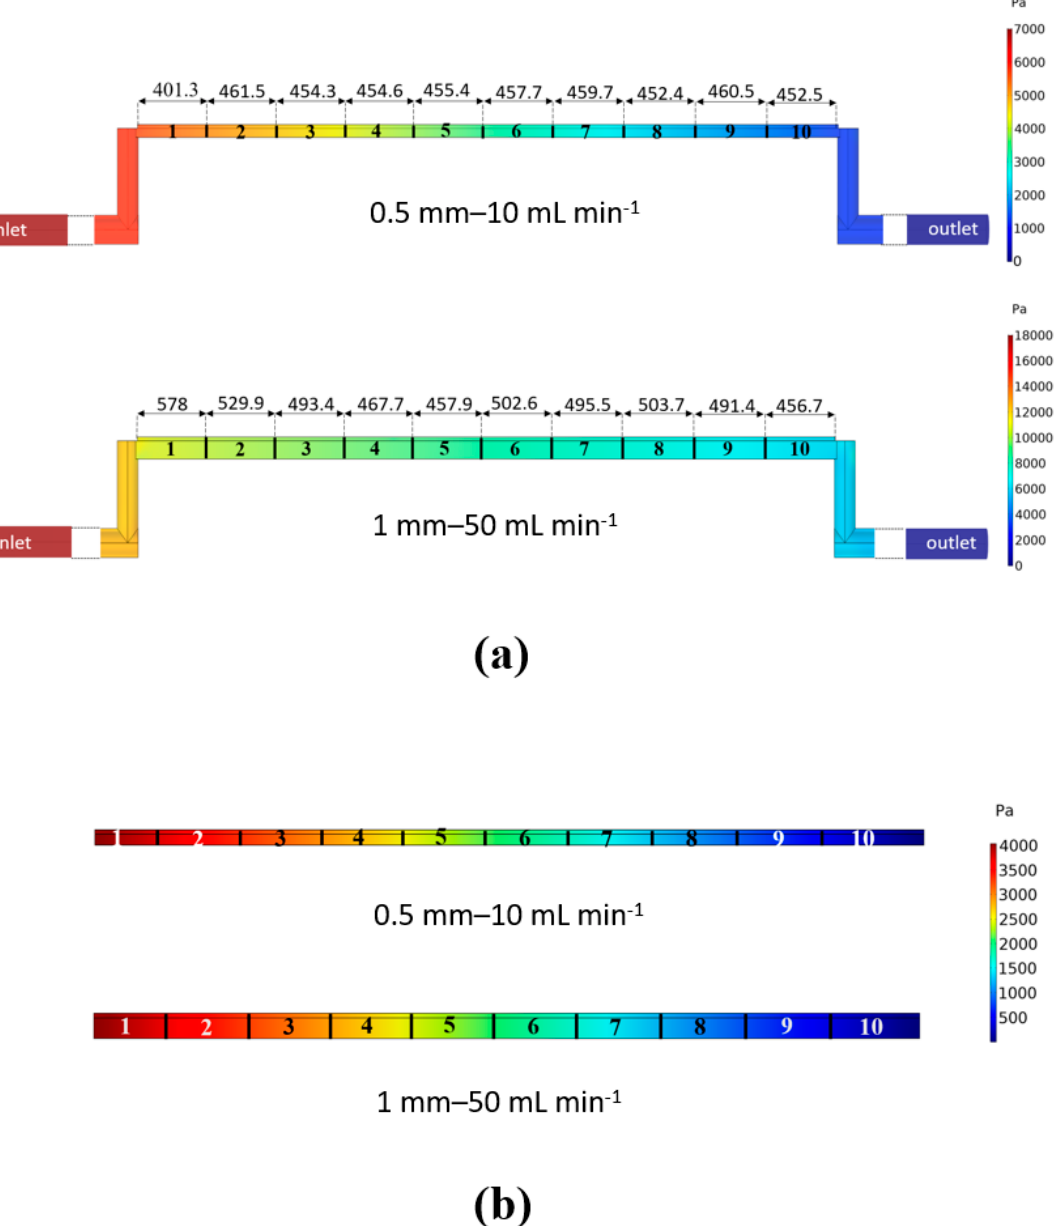
Figure 7. Predicted pressure drop distribution for ( a ) complex and ( b ) simplified geometries.